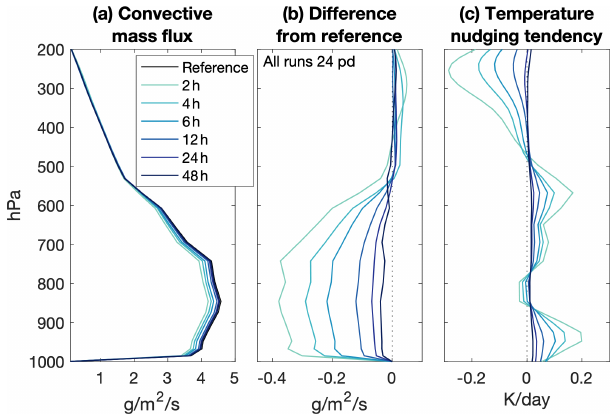
Figure 5. Tropical convective mass flux (a) mean and (b) differ- ence from the reference meteorology, and (c) temperature nudging tendency for all nudging timescales at 24 meteorology updates per day. Average taken from 20 ◦ S to 20 ◦ N.